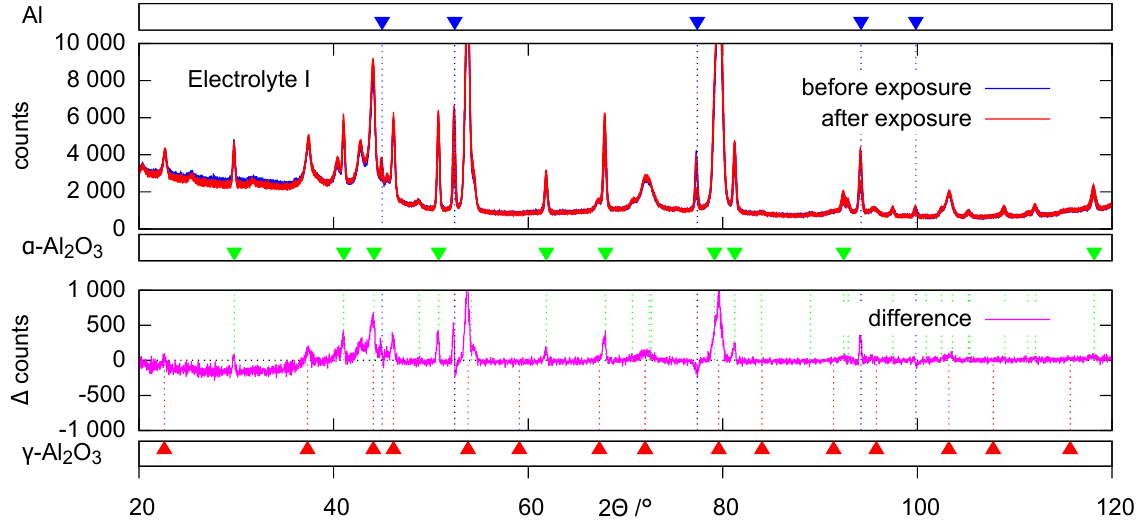
Figure 4. XRD diffractograms of the five PEO-coated samples exposed to electrolyte I before (blue) and after (red) the exposition experiments as well as the average difference graph (purple).